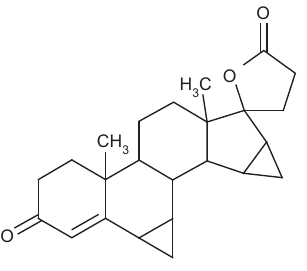
Figure 2 Structure of